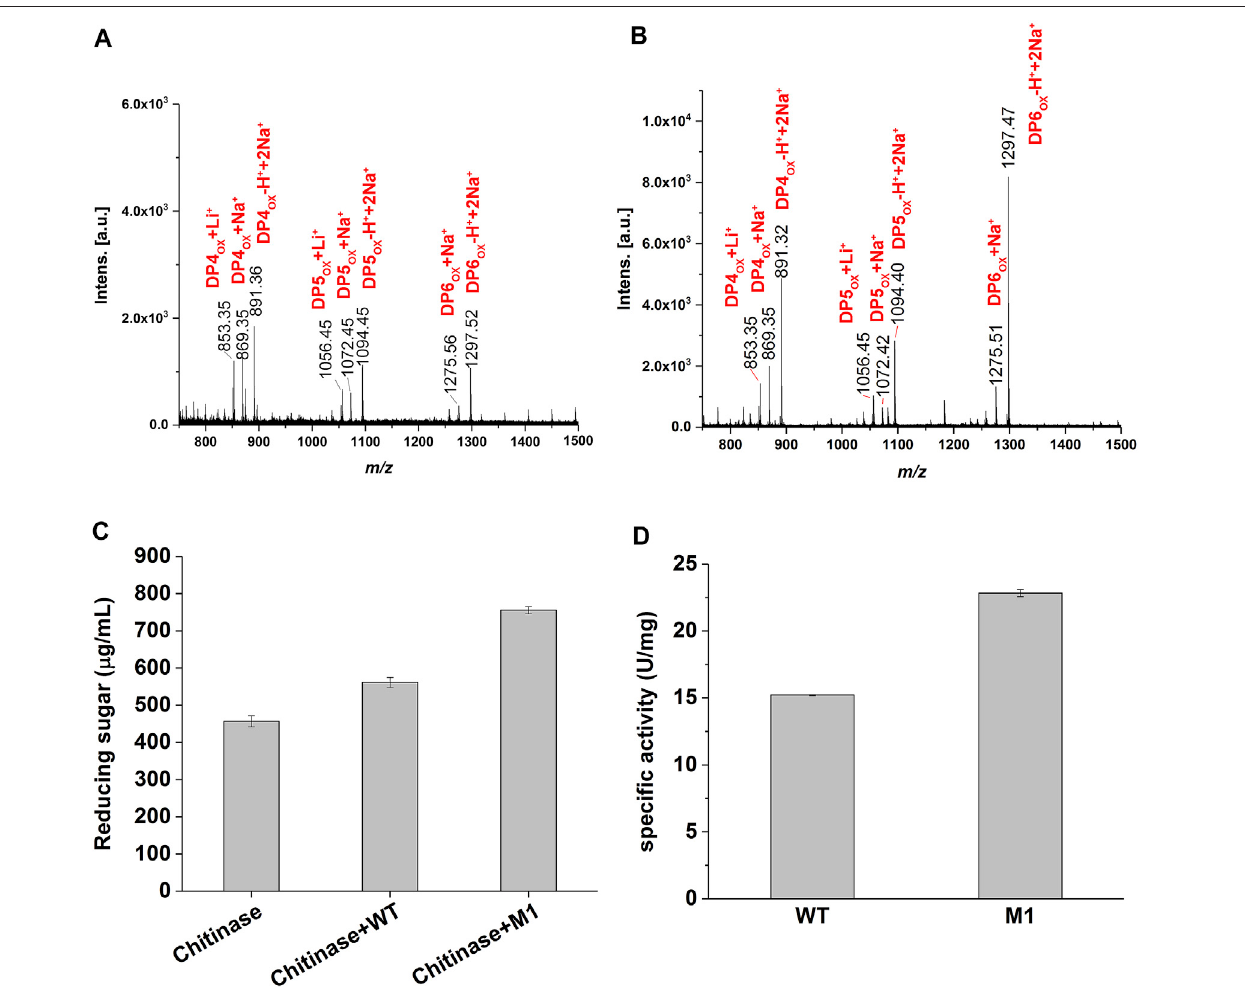
FIGURE 3 | Enzyme activity of CjLPMO10A cd and M1. (A) and (B) MALDI-TOF MS analysis of the products generated by the wild-type and M1 acting on α -chitin, respectively. DPnox indicates the degree of polymerization (DP) of oxidized chitooligosaccharides. (C) Synergistic degradation of α chitin by the wild-type or M1 with chitinase. The reaction mixtures were incubated at 37 ° C for 40 h, and the released reducing sugars was analyzed using the DNS method. (D) The speci fi c activity of the wild-type and M1 measured using 2,6-DMP as substrate.